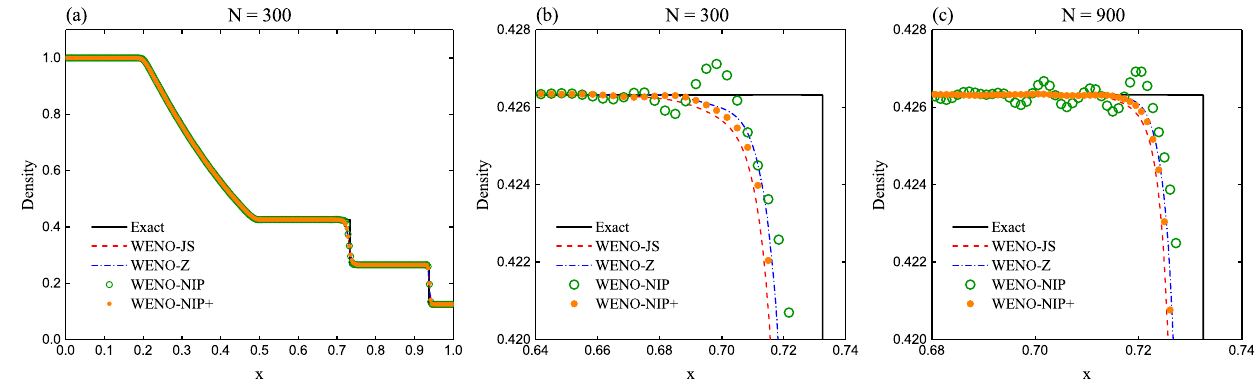
Figure 15. ( a ) Results of Sod’s shock-tube problem computed by WENO-JS, WENO-Z, WENO-NIP, and WENO-NIP+ at t = 0.25 with N = 300. ( b ) Zoom in near the discontinuity with N = 300. ( c ) Zoom in near the discontinuity with N = 900.